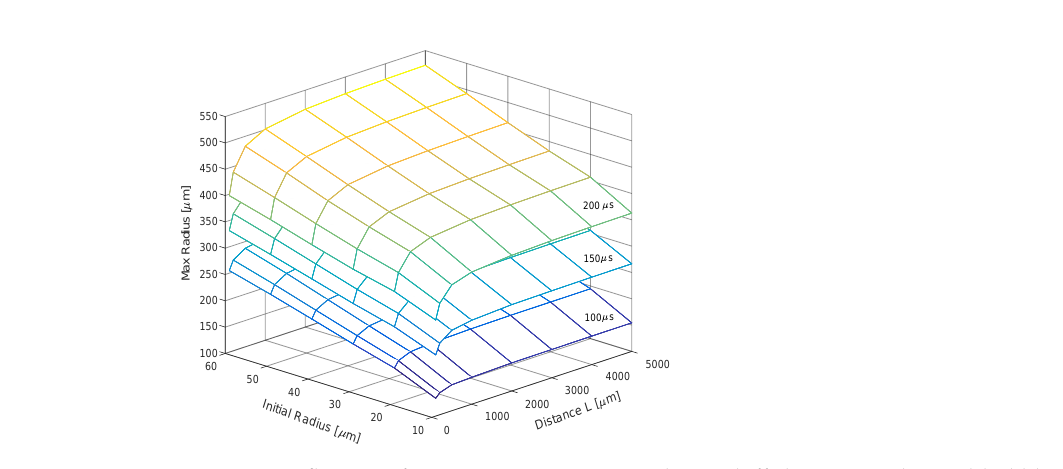
Figure 5. Influence of negative pressure period, standoff distance and initial bubble radius on bubble evolution.